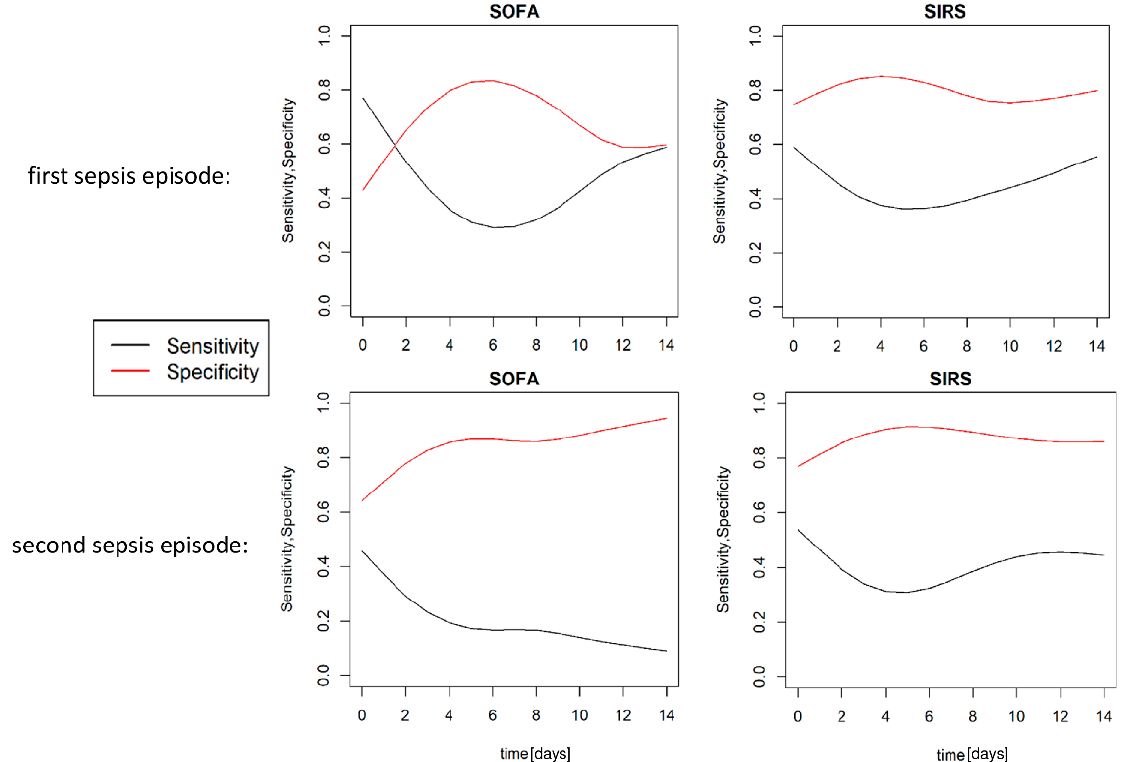
Figure 3. Sensitivity and specificity of sepsis detection in severe subarachnoid hemorrhage. Detection of sepsis occurrence via the sepsis-related organ failure assessment and systemic inflammatory response syndrome criteria for the first sepsis episode during critical care treatment for severe subarachnoid hemorrhage, as well as for a subsequent sepsis episode. Reports of the sensitivity and specificity of the recommended sepsis definitions according to sepsis-2 and sepsis-3 criteria. Table 3. Regression analysis of correlation of false positive SOFA detections to impaired Score modules. Table 2. Sepsis detection via SOFA score in SAH. SOFA Score Module Clinical Correlate Glasgow coma